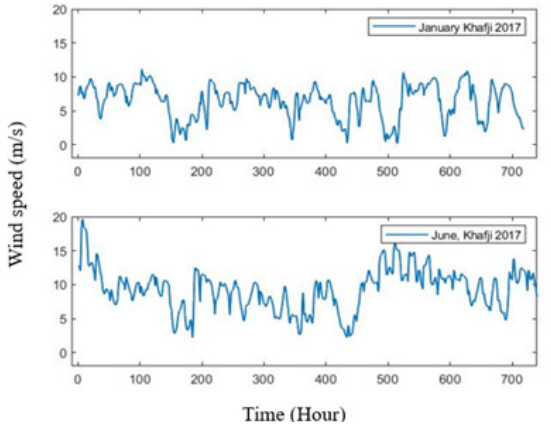
Figure 1. Wind speed measured at 50m height; Khafji, 2017.